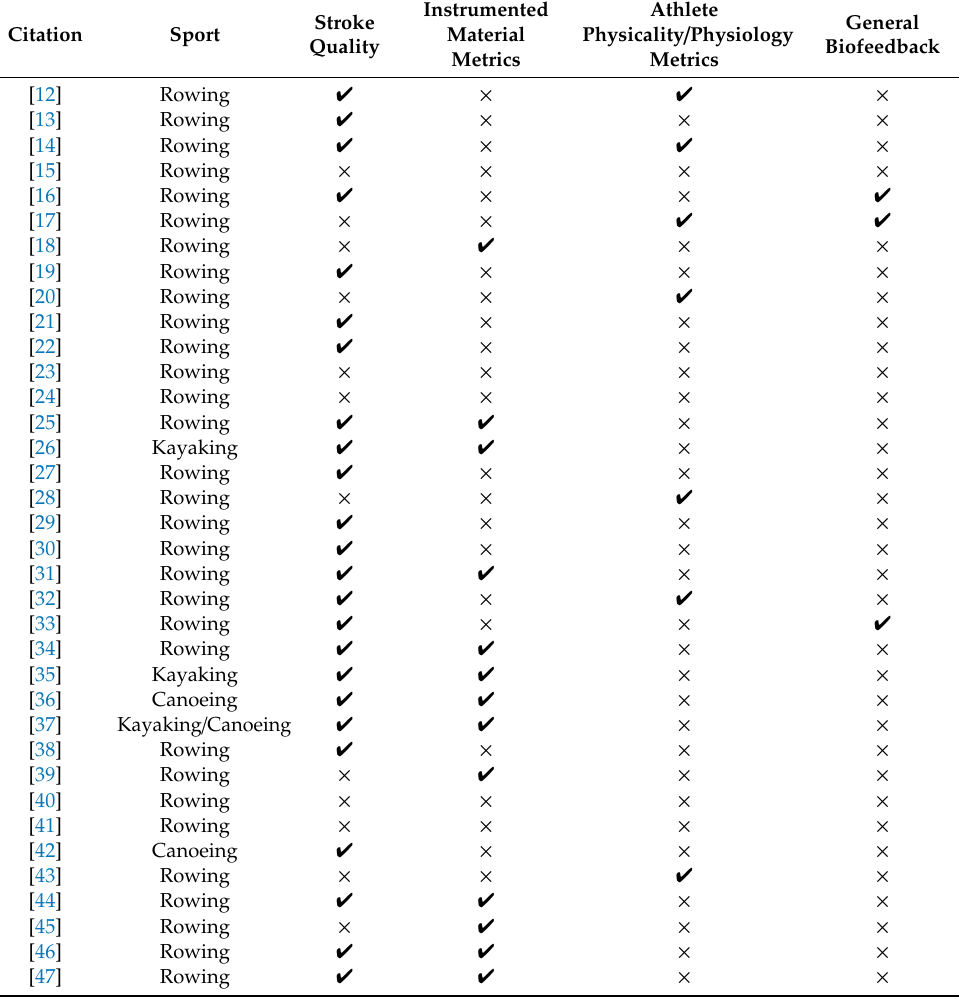
Table 2. Rowing performance